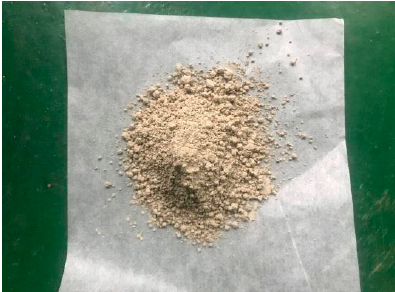
Figure 7. Photograph of the test sand. Energies 2020 , 13 , x FOR PEER REVIEW